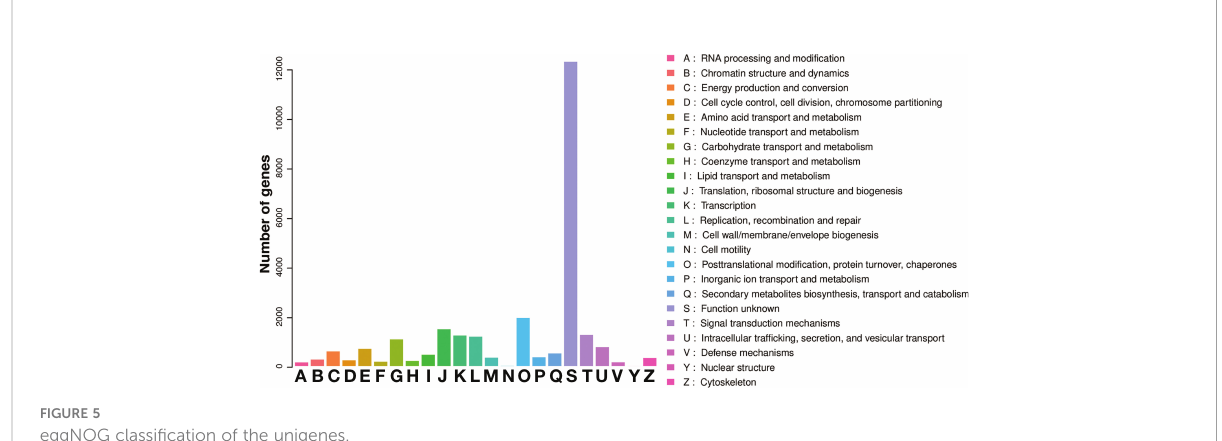
FIGURE 5 eggNOG classi fi cation of the unigenes.